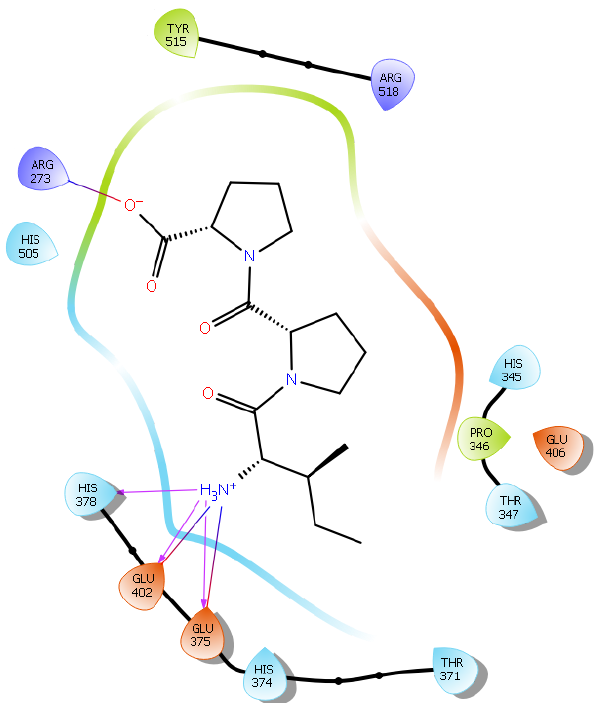
Figure 3. Docking results of the peptide IPP in the active site of the human angiotensin 2-converting enzyme (ACE2). Interactions of human ACE2 residues with the peptide IPP (represented in black) are indicated by arrows of different colors, with purple arrows representing hydrogen bond interactions and blue arrows representing salt bridge interactions.